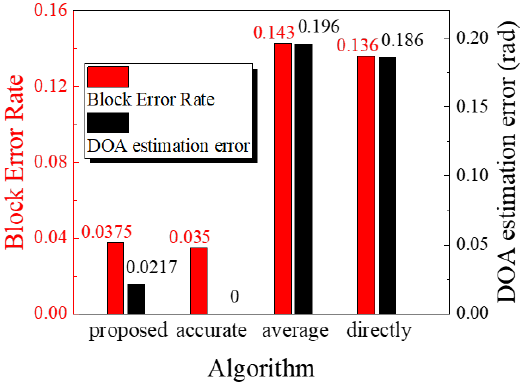
Figure 9. Block error rate (in red) and DOA estimation error (in black) with different algorithms: “proposed” corresponds to the proposed DOA estimation algorithm in this paper; “accurate” corresponds to the simulation with accurate DOA; “average” takes the average DOA of all the sub-arrays as the estimated DOA in simulation; and “directly” takes the DOA estimation of each sub-arrays as the estimated DOA in simulation.